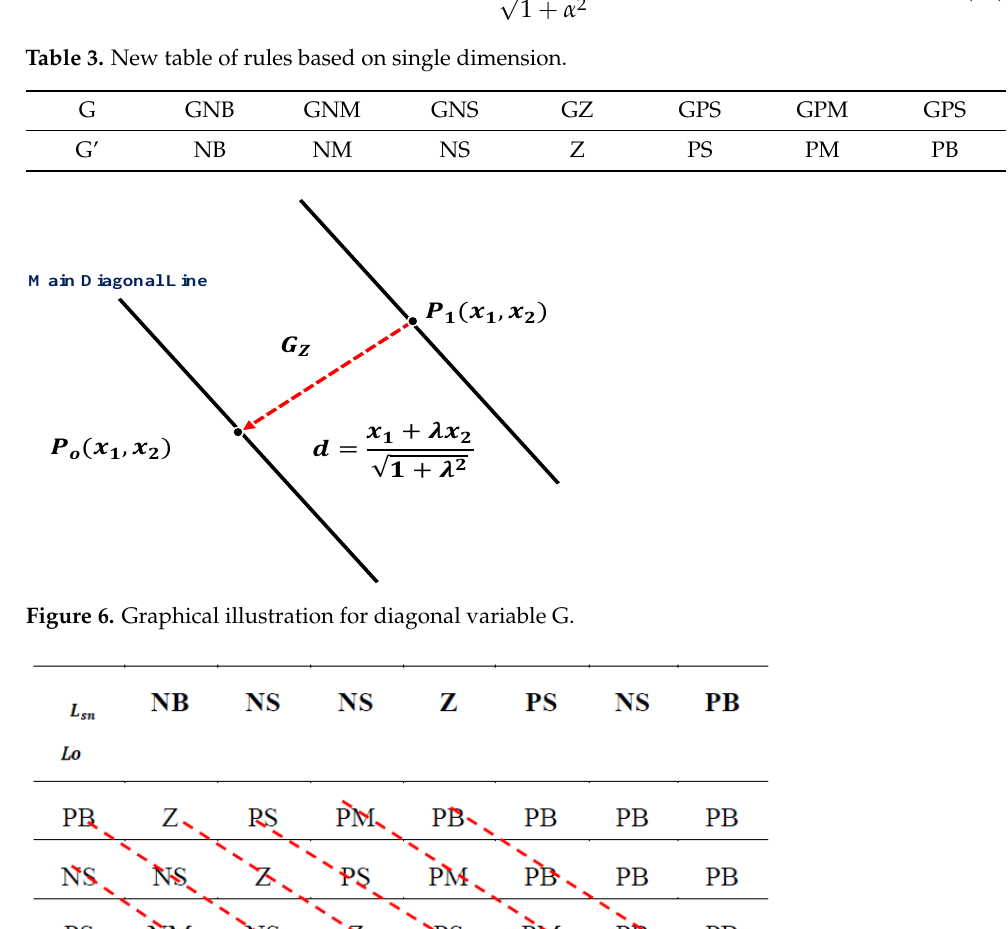
Figure 7. Using diagonals to derive the signed variable G. Table 3. New table of rules based on single dimension.